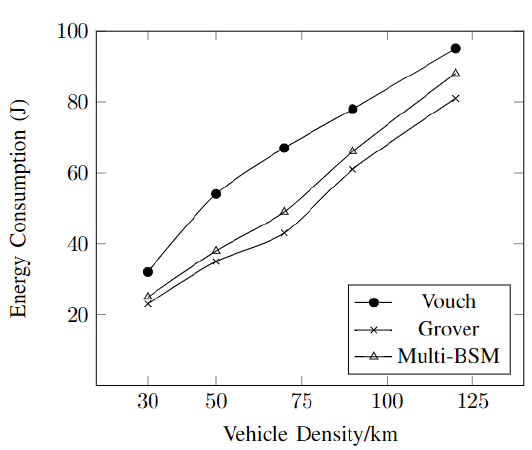
Figure 5. The energy consumption of the algorithms at the